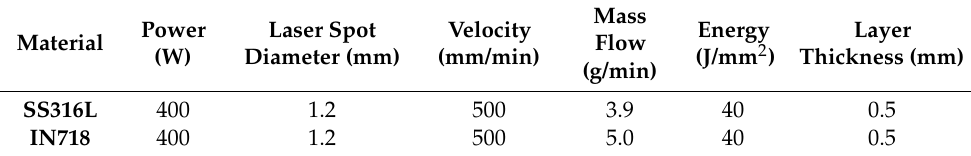
Table 2. LMD process parameters for the manufacturing of thin